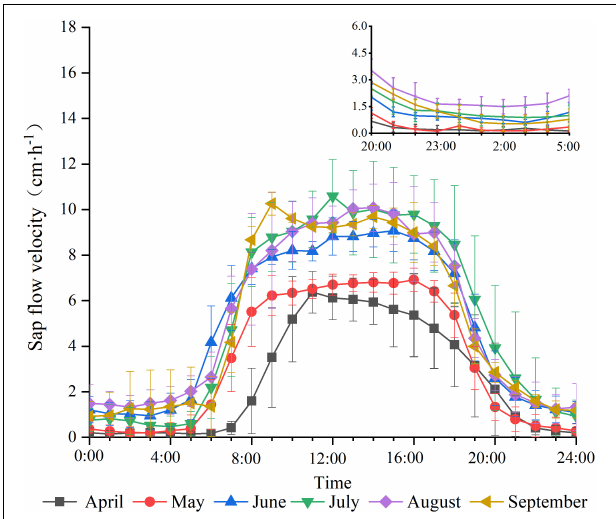
FIGURE 1 | Daily variation of sap flow velocity by month.